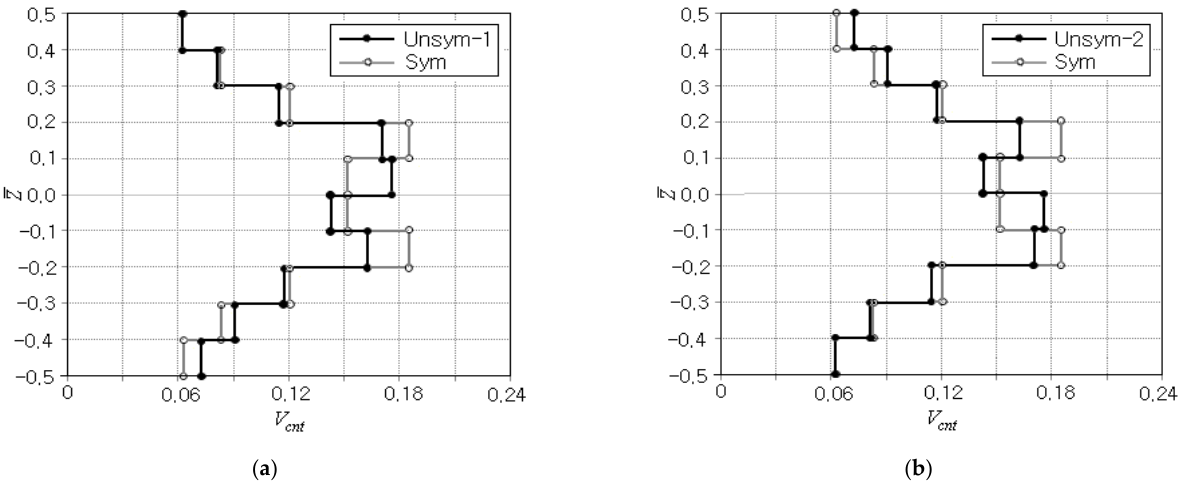
Figure 7. Optimal distributions of CNT volume fraction V ∗